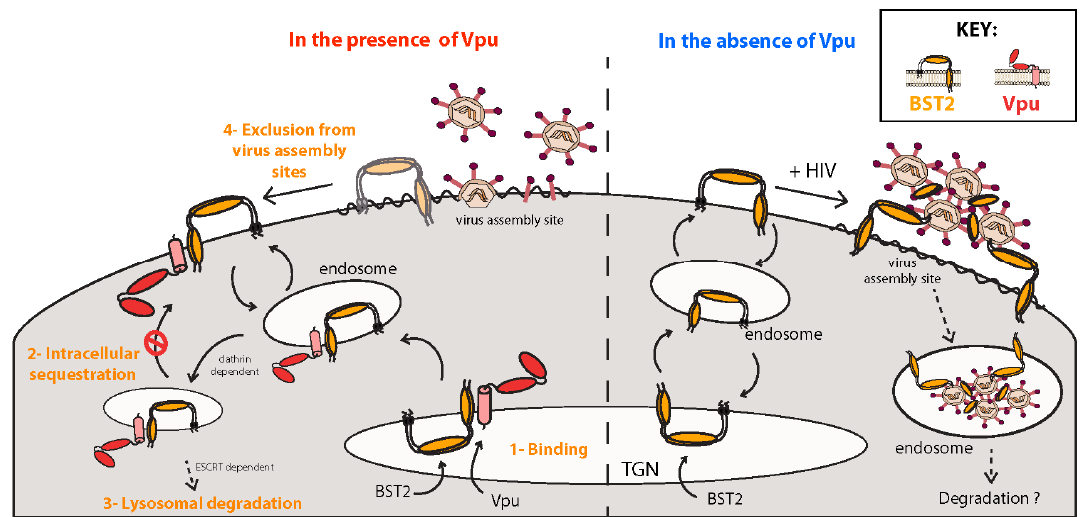
Figure 2. Multiple modes of Vpu-mediated bone marrow stromal cell antigen 2 (BST2) counteraction. Under normal conditions, de novo BST2 protein is supplied to the plasma membrane (PM) through the secretory system. Constitutive recycling of BST2 occurs from the PM to endosomes, as well as between endosomes and the trans -Golgi network (TGN) ( right ). During HIV-1 infection in the absence of Vpu, accumulation of BST2 at sites of viral assembly at the cell surface results in the incorporation of BST2 molecules into nascent virions, leading to inhibition of virus particle release. In select systems, these BST2-entrapped virions may be internalized and potentially degraded. During infection with Vpu-competent HIV-1, Vpu intercepts and binds BST2 within the vesicular system, resulting in their sequestration in endosomal structures in an AP-1 and clathrin-dependent manner ( left ). In the context of group M Vpu variants, sequestered BST2 proceeds to subsequent lysosomal degradation along the endosomal sorting complexes required for transport (ESCRT) pathway. Vpu can also bind BST2 at the cell membrane to induce its removal from sites of virus assembly using an AP-2 and clathrin-dependent system. This pool of BST2 may subsequently recycle into endosomal compartments for sequestration and degradation.